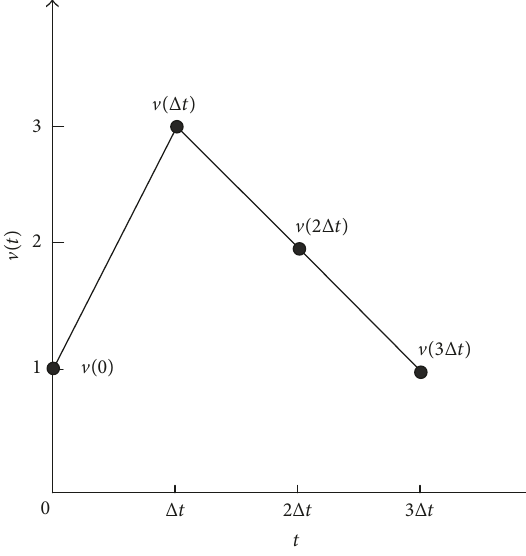
Figure 3: Travel speed